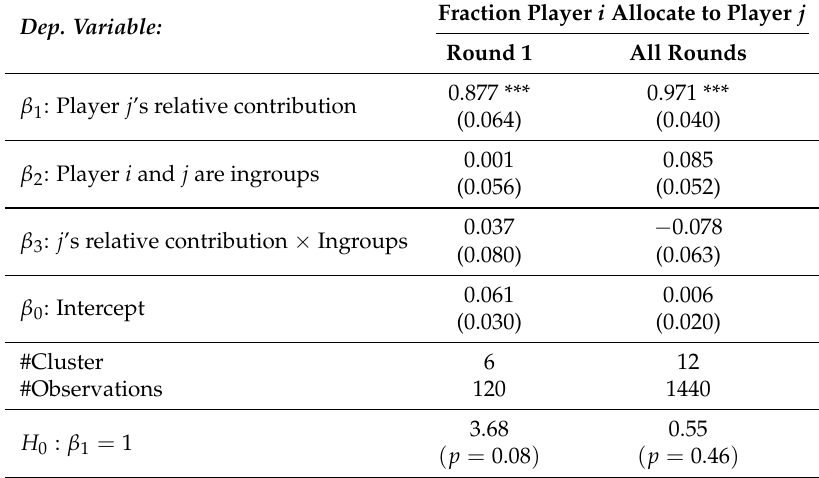
Table 2. Determinants of Allocation Decisions.